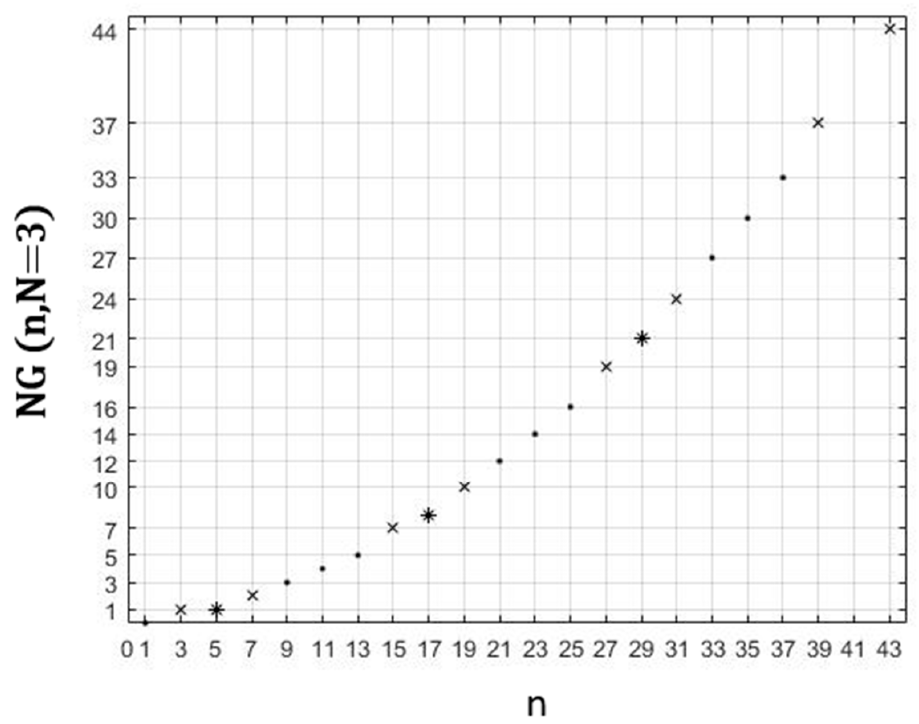
Figure 10. Dependence of the number of graphs NG (n, N = 3) as a function of odd n. • : (n ∈ { 2 k + 1/ k ∈ IN } , odd p); x : (n ∈ { 3 + 4 k / k ∈ IN } , even p); * : (n ∈ { 5 + 4 k / k ∈ IN } , even p).